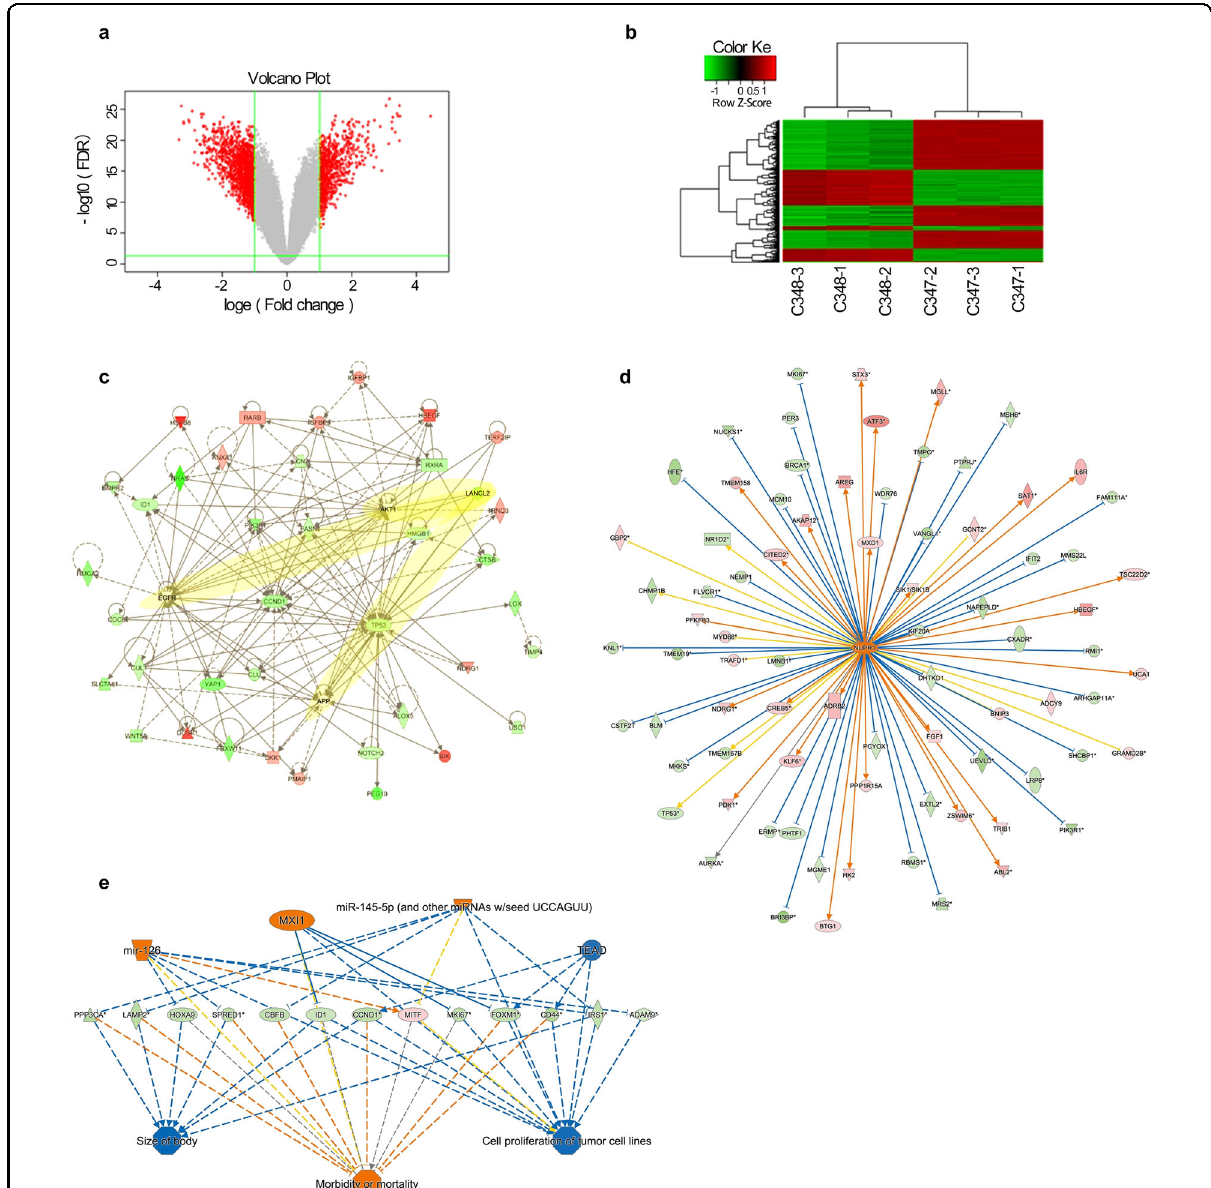
Fig. 7 LANCL2 knockdown enriched cancer-related signaling pathways and proteins. a Volcano plot analysis of gene chip array results revealed 496 upregulated and 839 downregulated DEGs after LANCL2 knockdown (DEG criteria: p < 0.05; absolute fold-change >2.0). b Heatmap of DEGs after LANCL2 knockdown. Each row refers to one DEG. Each column represents one sample. The legend depicts the color code for Row Z-score fold- change values. c IPA interaction network analysis of DEGs detecting putative regulatory interactors of LANCL2. Note the highlighted putative interactions between LANCL2-EGFR, LANCL2-APP, and LANCL2-Akt. d IPA upstream regulator analysis of DEGs evidencing putative transcriptional regulators of LANCL2. e IPA downstream effects analysis of DEGs identifying putative dysregulated biological